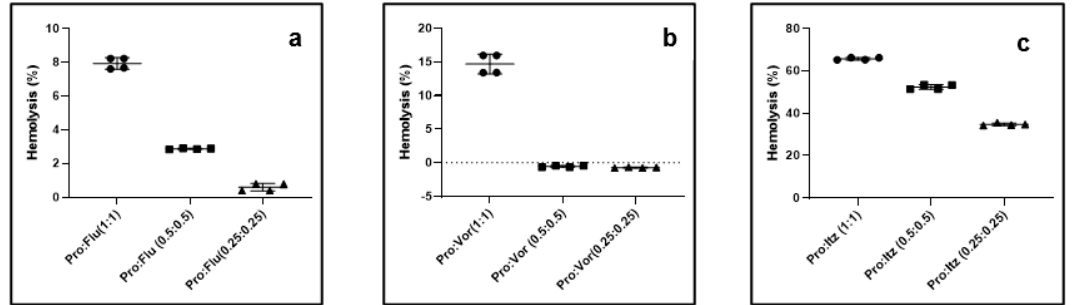
Figure 3. Hemolytic activity of propranolol–azole antifungal combinations for rabbit erythrocytes. ( a ) Propranolol– fl uconazole; ( b ) propranolol–voriconazole and ( c ) propranolol–itraconazole. The value indicates the drug concentration in mg/mL.